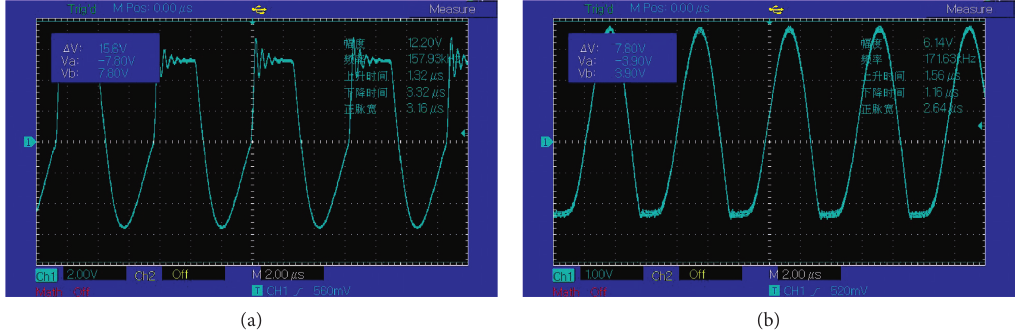
Figure 10: Experimental voltage waveform. (a) Primary side input voltage waveform. (b) Secondary side output voltage